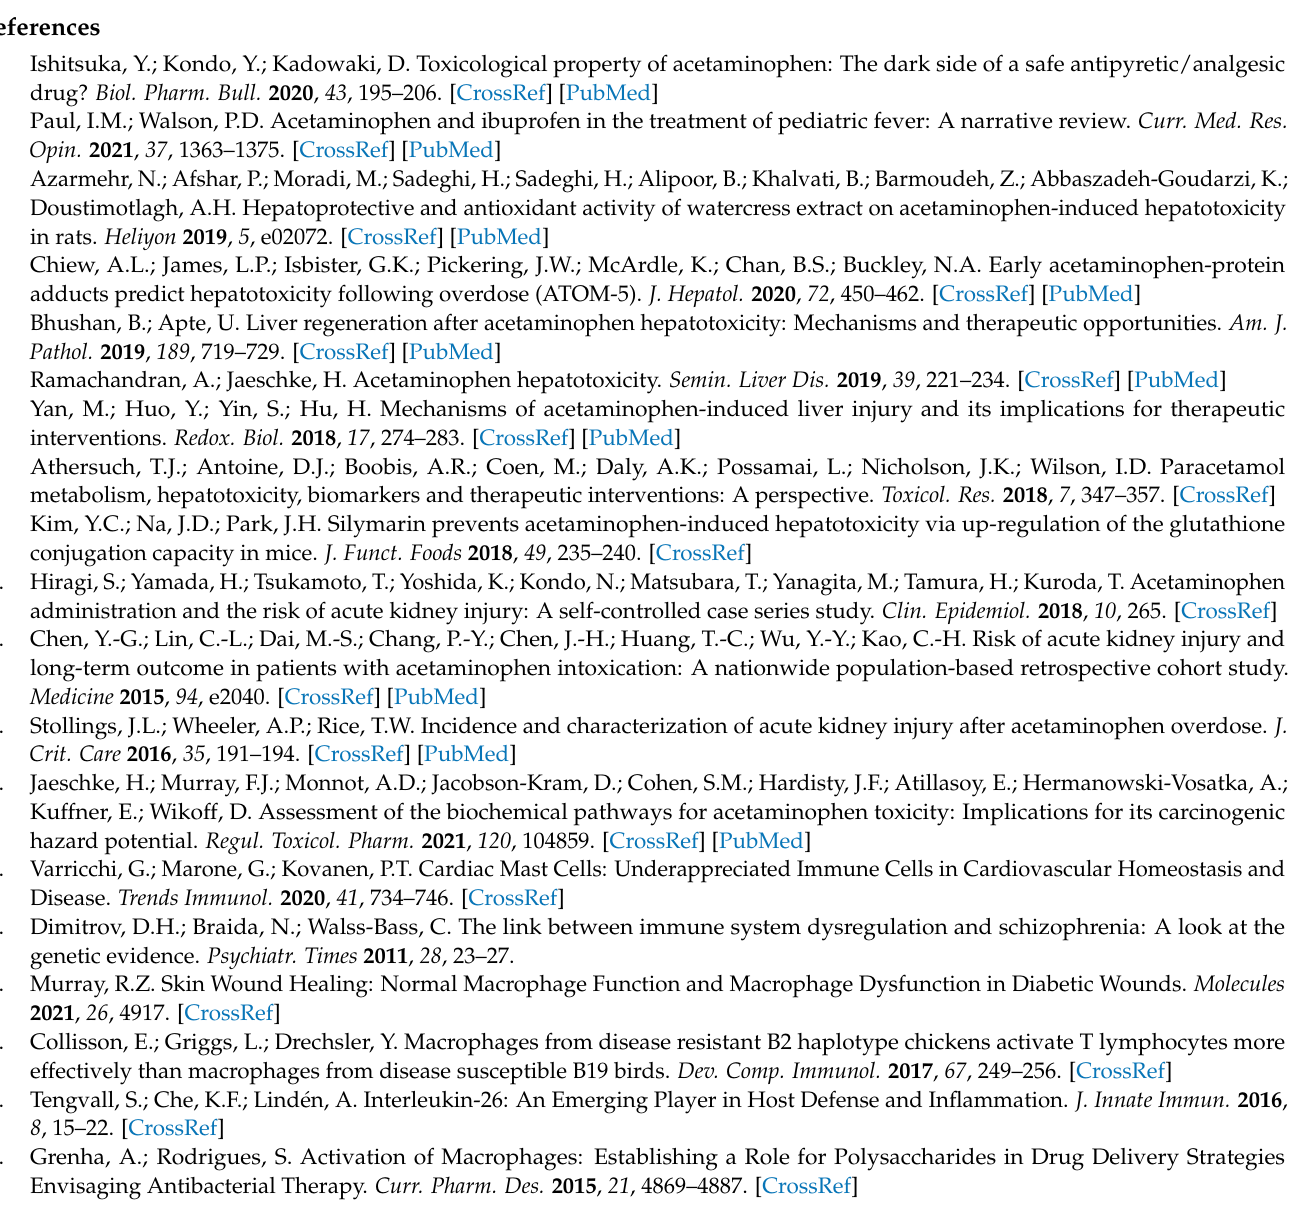
(HU); Table S2: Localization of differentially expressed proteins in